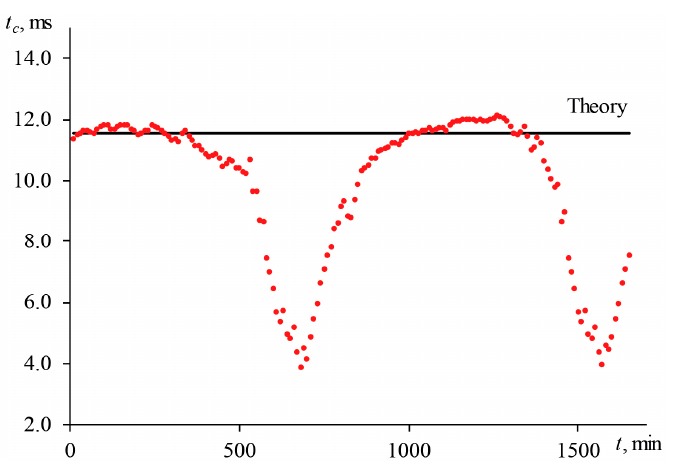
Figure 5. The behavior of the characteristic time of an aqueous solution of ferroin (2.5 µmol/L); wide- focused configuration ( 𝜔 (cid:3032)(cid:2868) = 82 µm, Figure 2, Table 3).